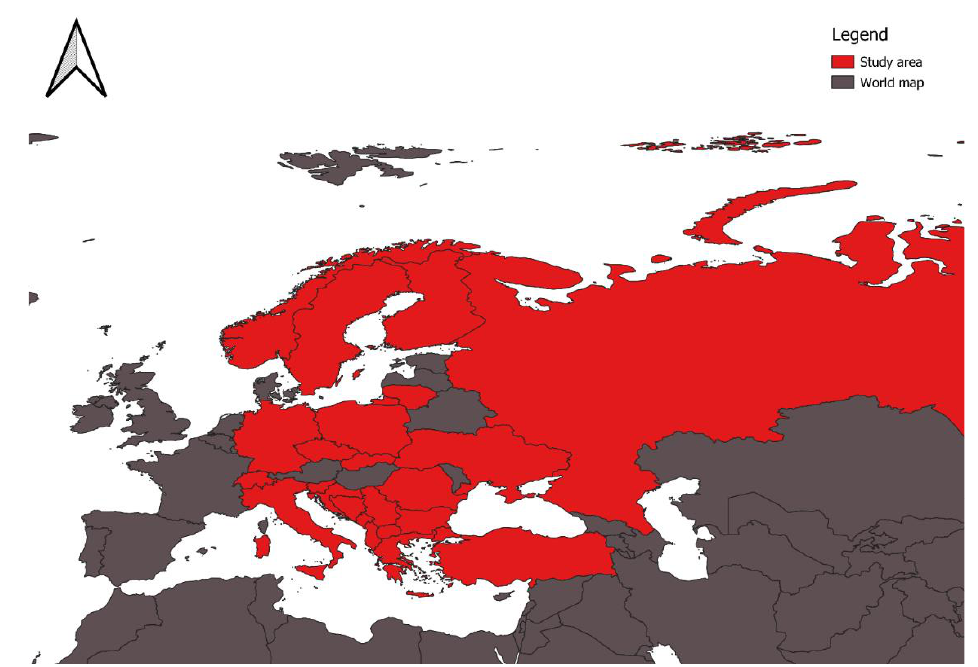
Figure 2. Location of the retrieved literature.